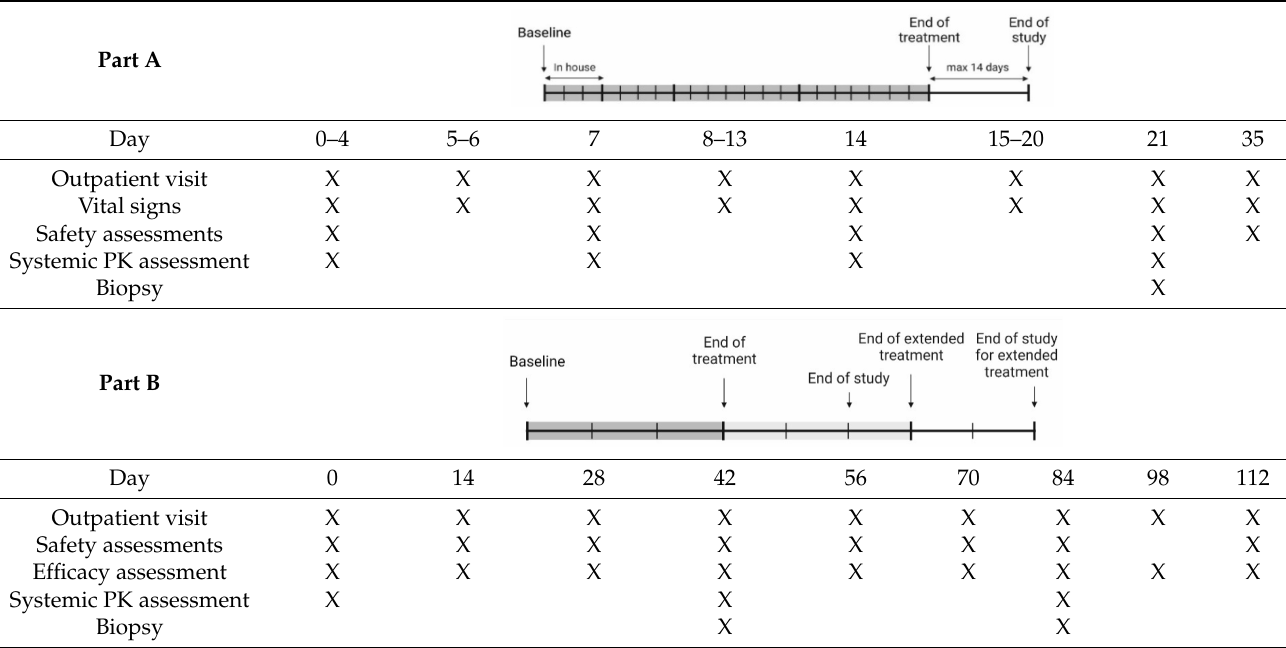
Table 1. Study design of part A with HVs (n = 6) and part B with MF patients (n = 19). Patients